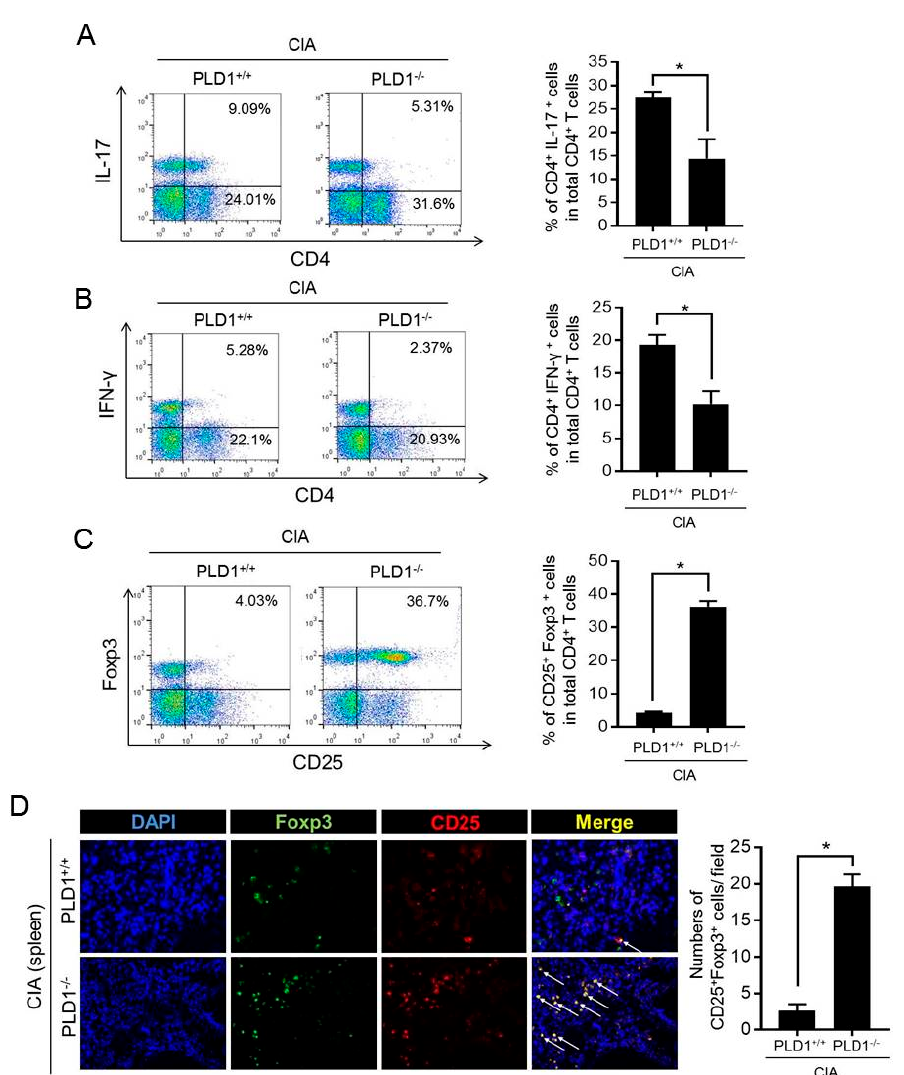
Figure 3. PLD1 deficiency decreases the population of Th1 / Th17 cells and increases the population of Treg cells in collagen-induced arthritis (CIA) mice. ( A ) Representative flow cytometry profile of IL-17 + cell frequency among CD4 + T cells in the spleens of indicated mice with CIA (left); quantitative analysis of the CD4 + IL-17 + cell population in spleen CD4 + T cells from mice with CIA (right). ( B ) Representative flow cytometry profile of CD4 + IFN- γ + T-cell frequency in the spleens of indicated mice (left); quantitative analysis of the CD4 + IFN- γ + T-cell population (right). ( C ) Representative flow cytometry profile of CD25 + Foxp3 + cell frequency among splenic CD4 + T cells (left); quantitative analysis of the CD25 + Foxp3 + Treg cell population in splenic CD4 + T cells (right). ( D ) Immunofluorescence staining of Foxp3 and CD25 in the spleen of the indicated mice with CIA (left); quantification CD25 + Foxp3 + cell number. Treg cells are indicated by arrows. Original magnification, × 400. 3 fields per mouse spleen, 6 mice per group. * p < 0.05. The analysis was performed in CIA-challenged PLD1 +/+ and PLD1 − / − mice at day 42. Results are representative of at least six independent experiments and are shown as mean ± standard error of the mean (SEM).